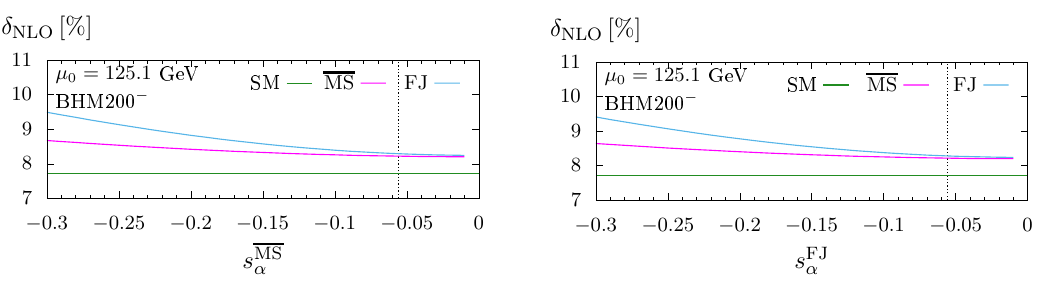
Figure 28 . As in (cid:12)gure 13, but for benchmark scenario BHM200 (cid:0) .